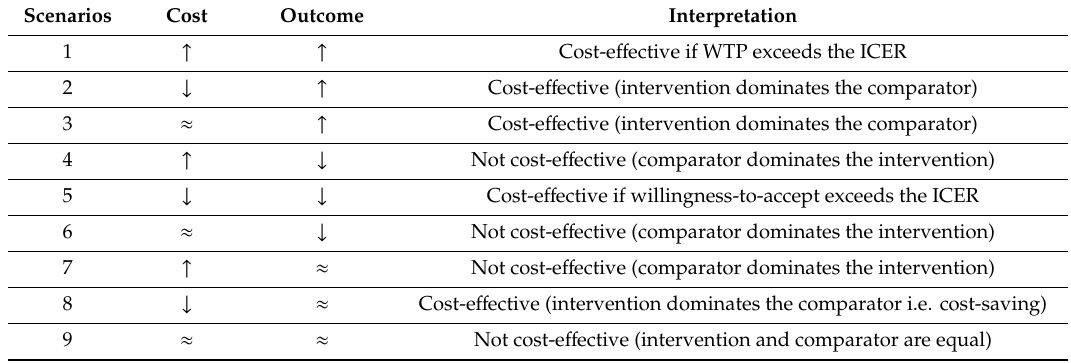
Table 2. Decision rules for economic evaluations (intervention vs.